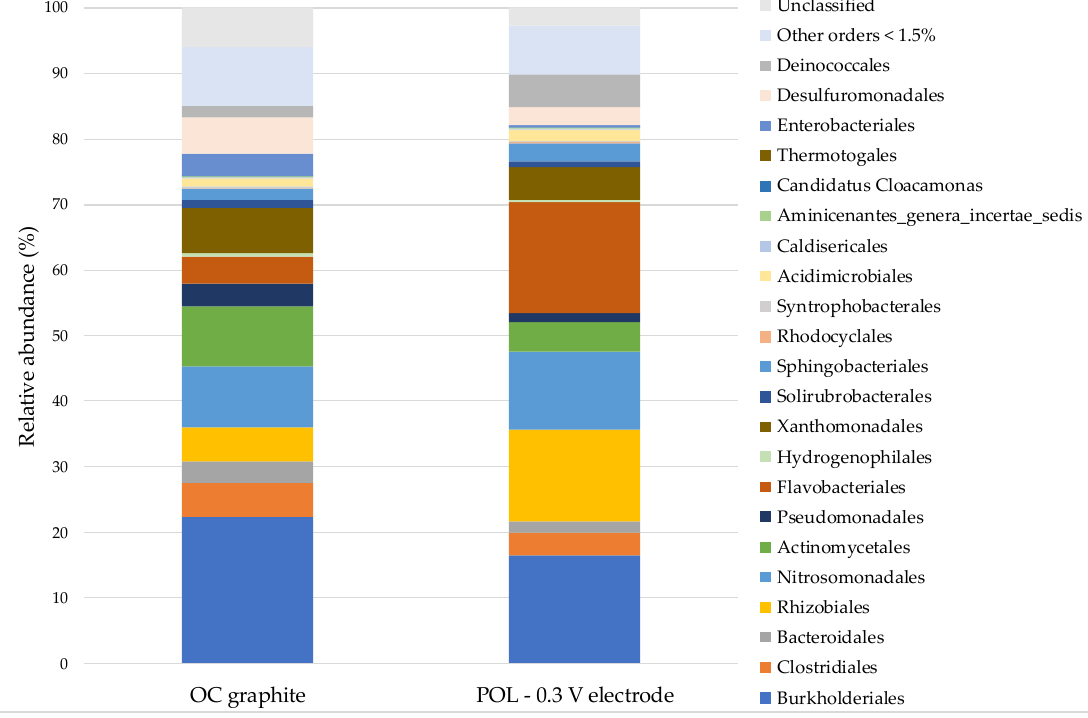
Figure 6. Bacterial community structures at order level of the biofilm developed on graphite of the open circuit system (OC graphite) and on polarized electrode (POL −0.3 V electrode). “Other orders < 1.5%” indicated strains with abundance less than 1.5%.